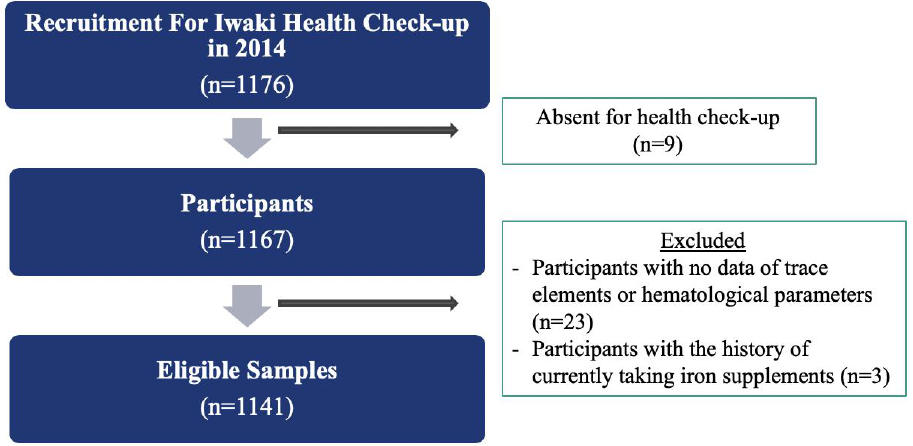
Figure 1. A flowchart for analytical samples. Table 1. General characteristics of participants ( n = 1141).